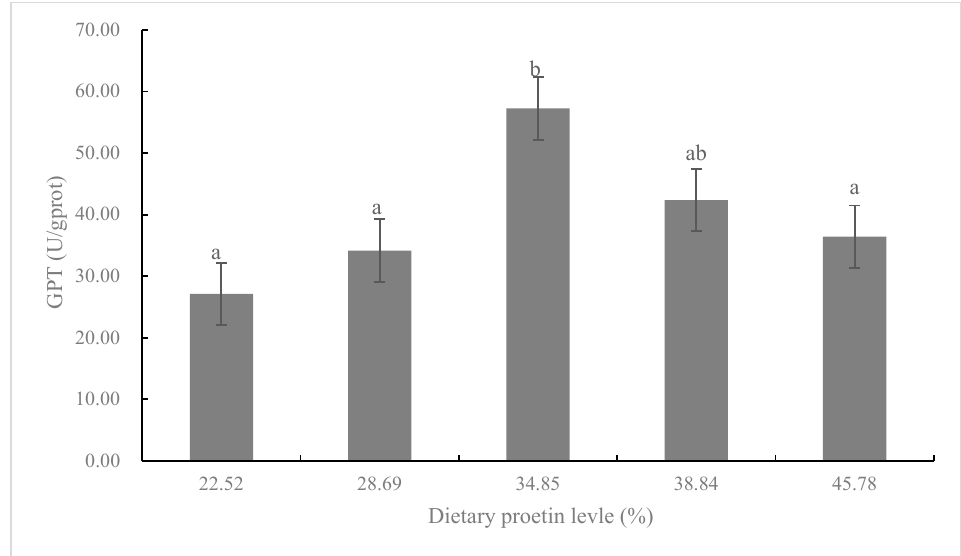
Figure 5. Glutamic-pyruvic transaminase (GPT) activity of juvenile K. punctatus fed diets containing different CP levels. Value columns with different letters mean significant difference ( p < 0.05).